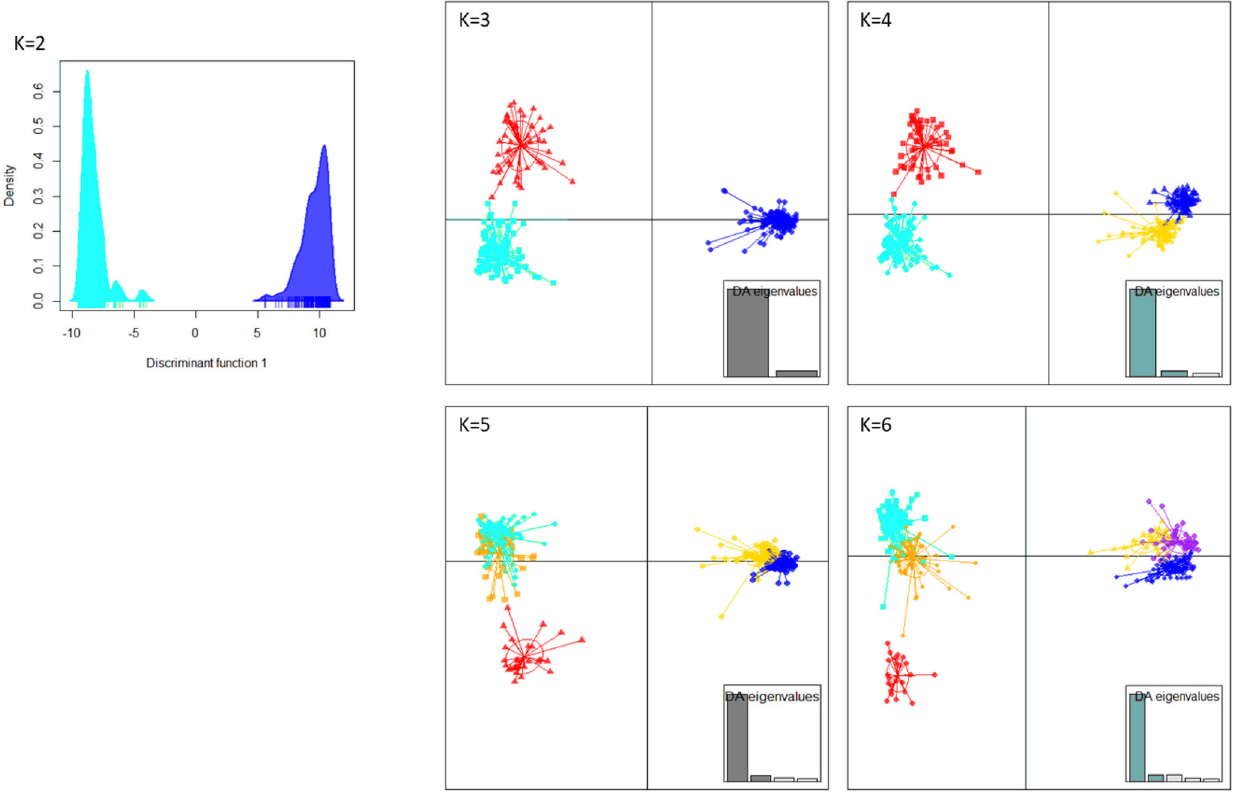
Fig. 3 Scatterplot representing the Discriminant Analysis of Principal Components clusters for the 396 French X. fastidiosa infected samples for k = 2 to 6 inferred by use of the VNTR-13 scheme. The eigenvalues showed that the genetic structure was captured by the fi rst two principal components retained onto axis 1 (horizontal axis) and axis 2 (vertical axis). The dots represent the individuals, and the clusters are shown as inertia ellipses. Clusters turquoise, red and orange grouped ST6 samples and clusters blue, yellow, and purple grouped ST7